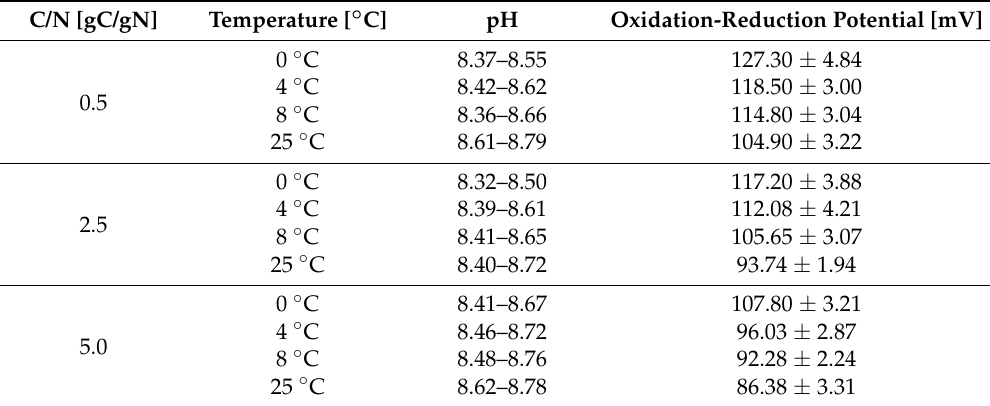
Table 3. Physicochemical properties of treated wastewater.